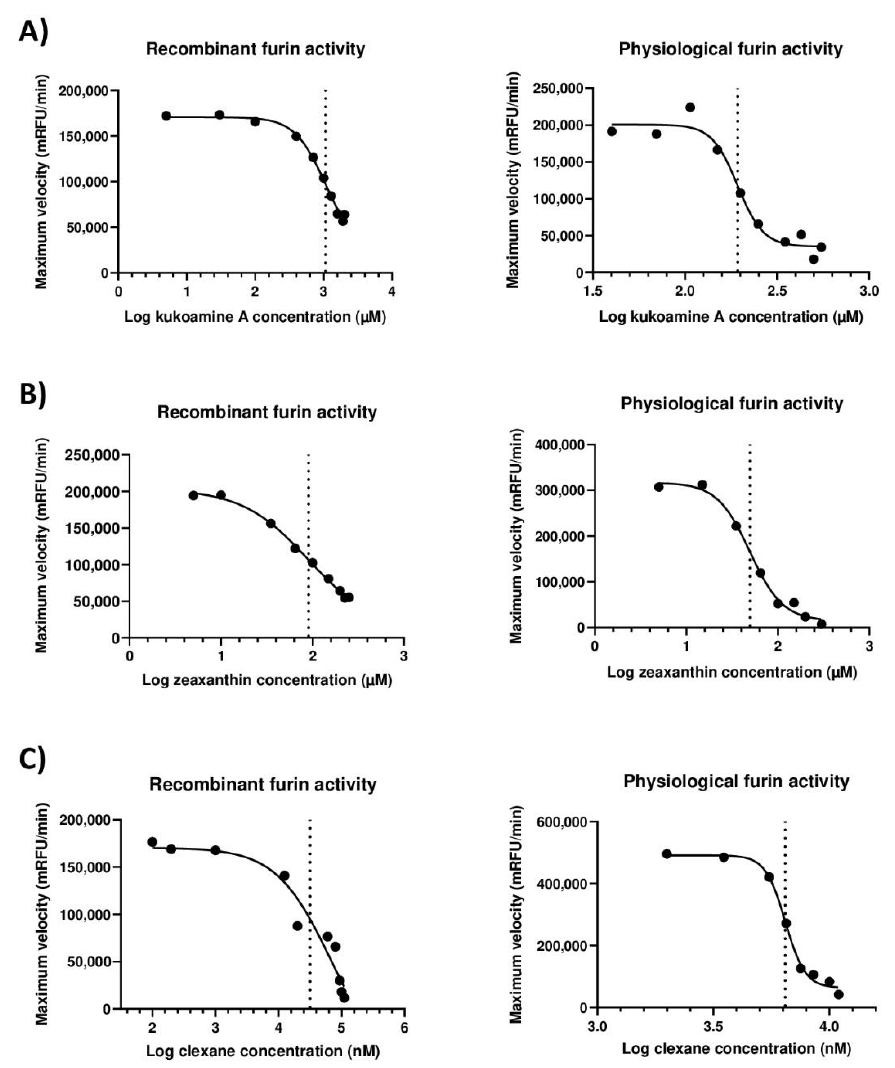
Figure 1. Dose-dependent inhibition of furin activity by Kukoamine A, Zeaxanthin, and Clexane. ( A ) Kukoamine A inhibited the activity of both recombinant and physiological furin. ( B ) Zeaxanthin inhibited the activity of both recombinant and physiological furin. ( C ) Clexane inhibited the activity of both recombinant and physiological furin. Vertical dotted line represents IC50 value for each compound. mRFU/min : millirelative fluorescence units/minute; Log: decimal logarithm.